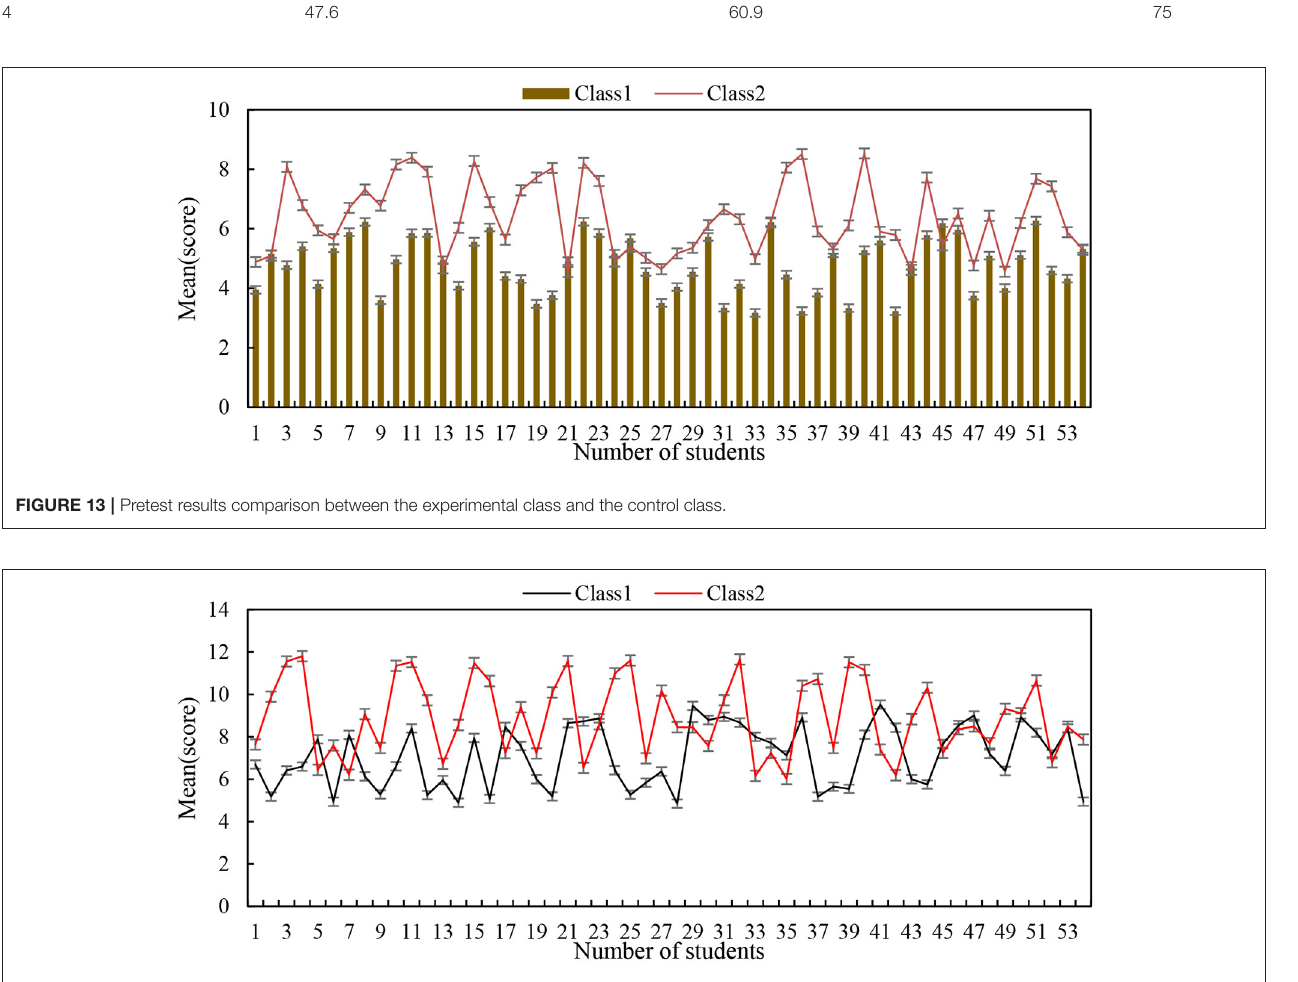
FIGURE 14 | The test results of the two classes after the